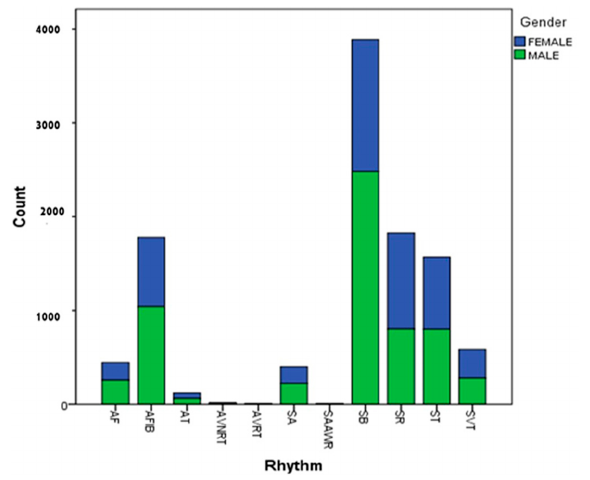
Figure 2. Frequency of rhythm by sex.